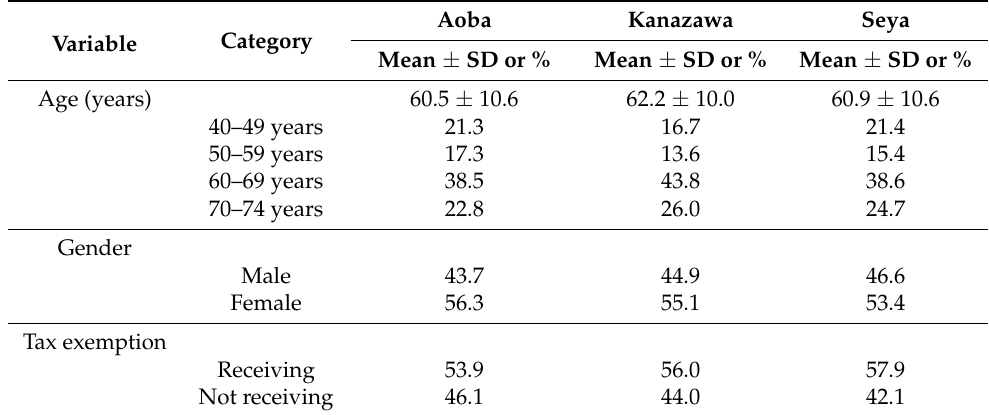
Table 2. Participant characteristics at baseline by residential area ( N = 131,295).